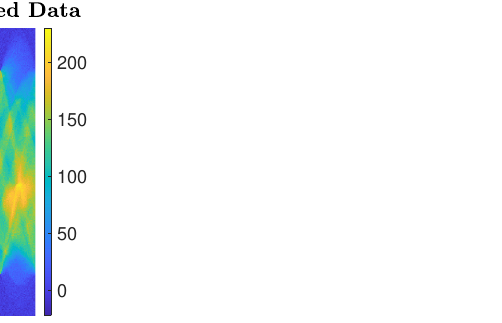
Figure 9. Experiment 3. Computed tomography test problem: the true object to be imaged (phantom) is displayed on the left and the collected data (sinogram) are displayed on the right.